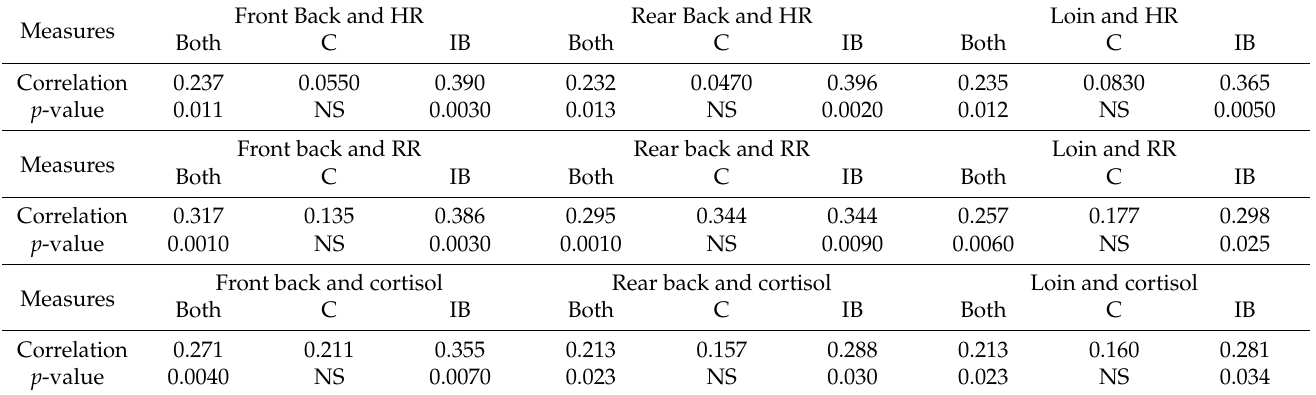
Table 9. Correlation between skin surface temperatures of the three sites of horse’s body (front back, rear back, loin) and 3 measurement parameters (HR, RR, and plasma